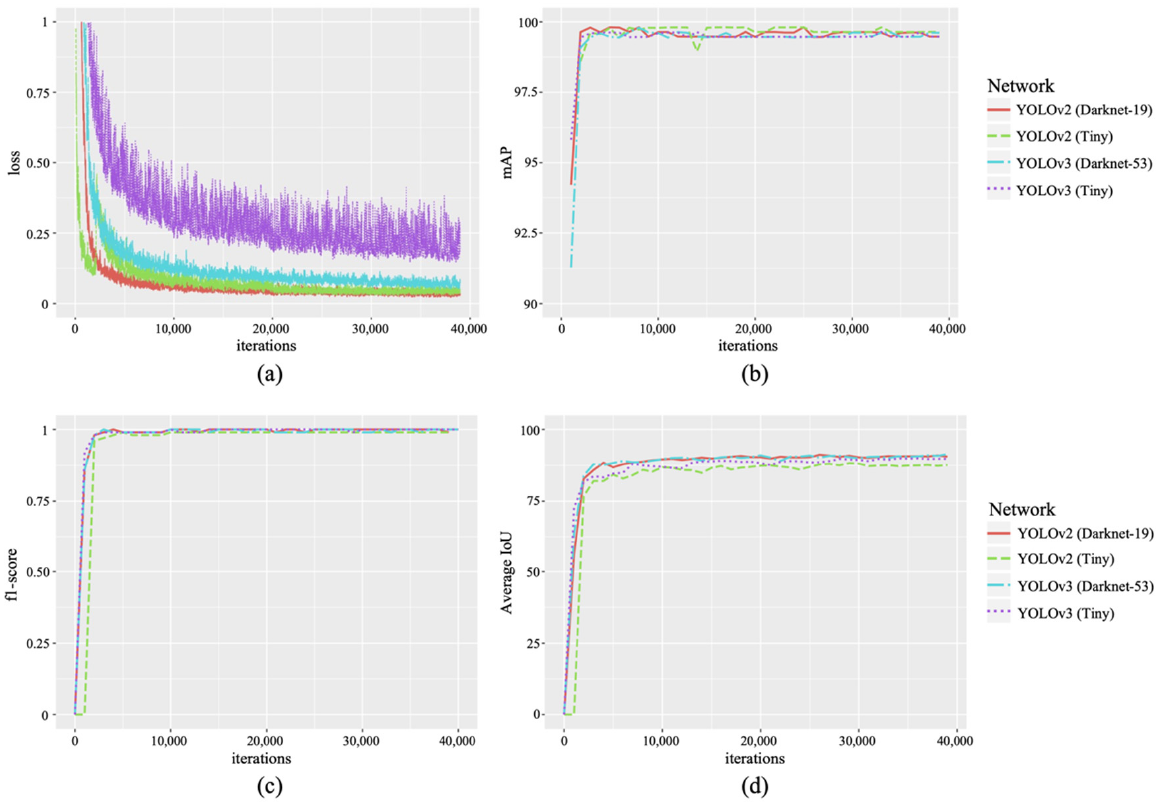
Figure 13. Validation results of bloomed flowers and immature fruit detection: ( a ) loss; ( b ) mAP; ( c ) f1-score; and ( d ) average IoU. mAP: Mean Average Precision; IoU: Intersection over